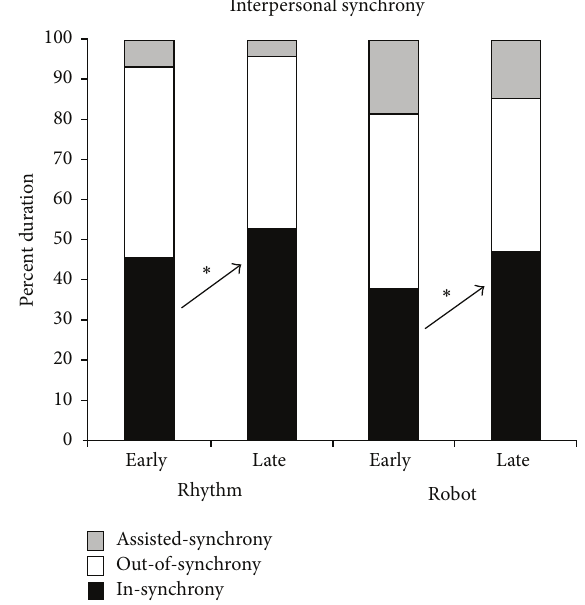
Figure 5: Training-related changes in interpersonal synchrony in the rhythm and robot groups. Error bars represent standard errors. ∗ 𝑝 < 0.05